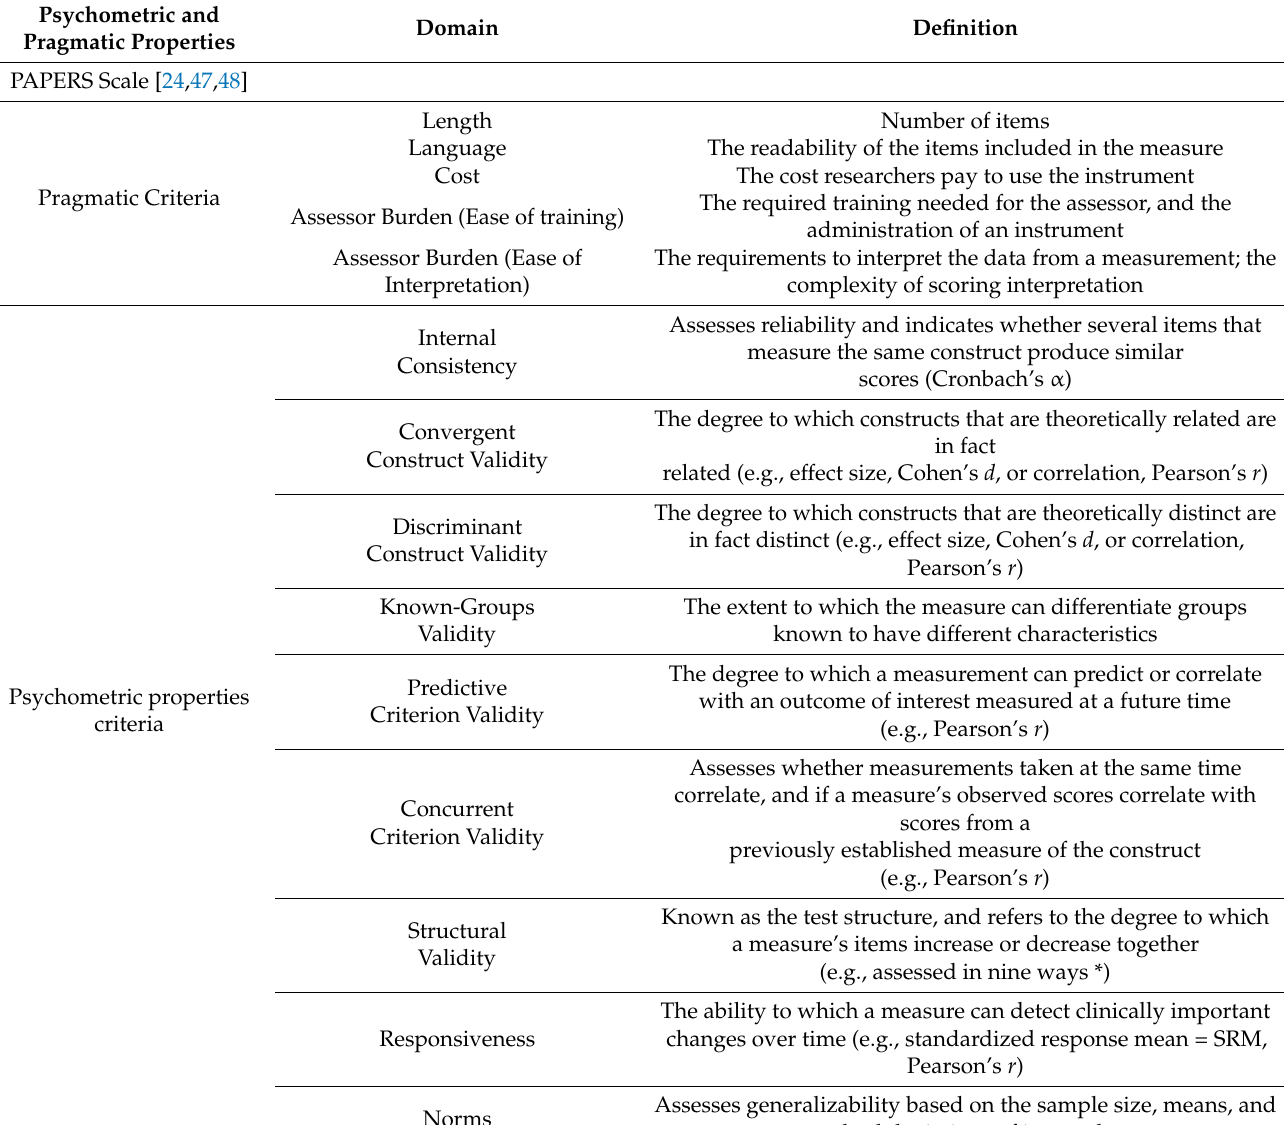
Table 3. Psychometric and pragmatic domains and their